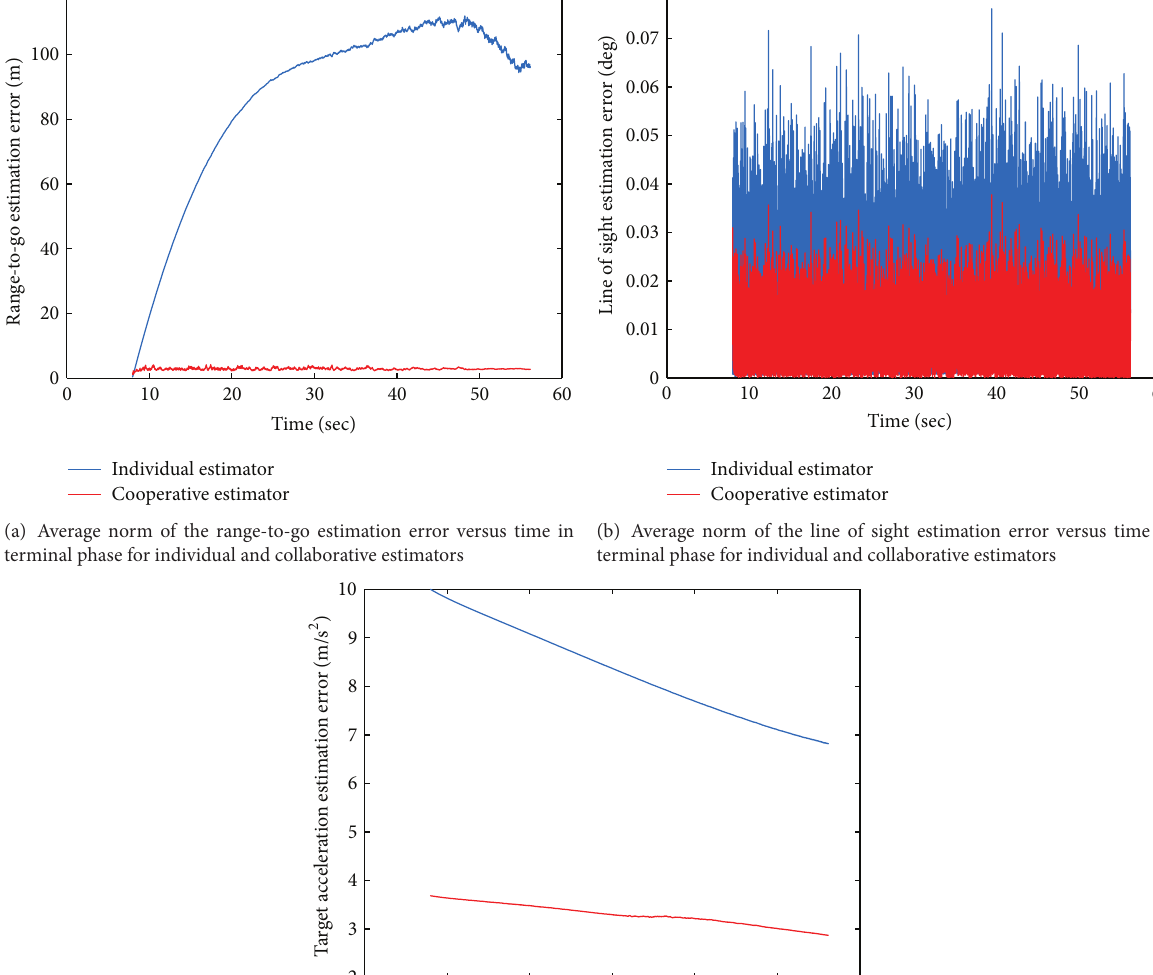
(c) Averagenormofthetargetaccelerationestimationerrorversustime in terminal phase for individual and collaborative estimators Figure 10: Filter performance versus time in terminal phase for intercepting low altitude-high velocity target.